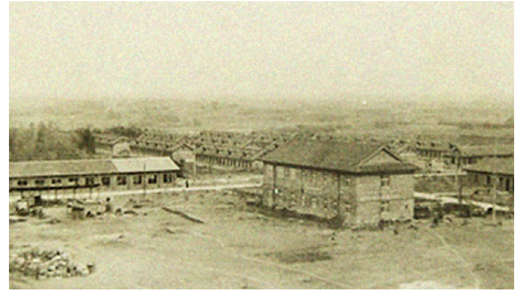
Figure 1. The Chengdu Institute of Biological Products in its early